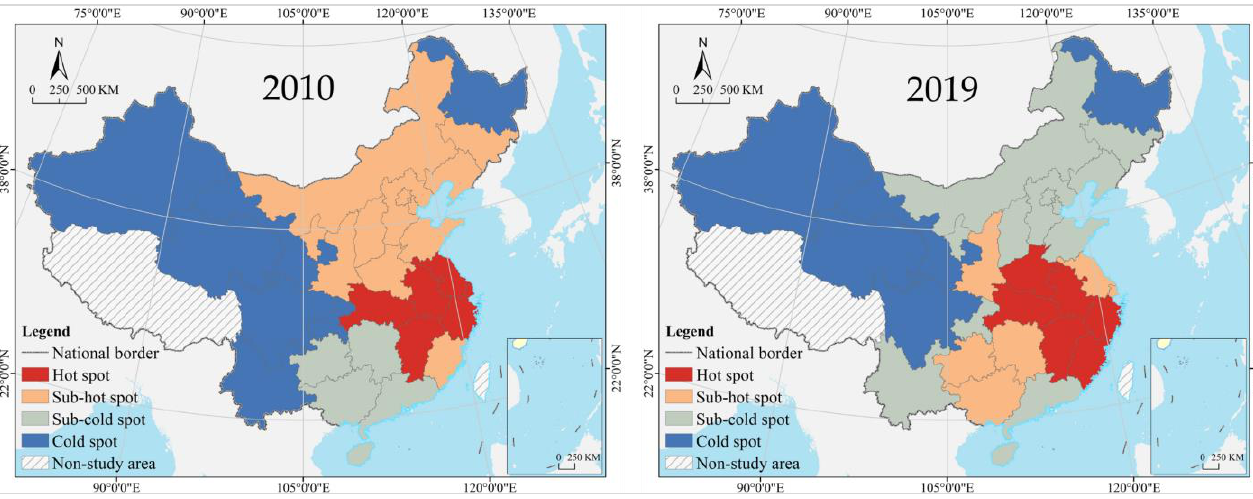
Figure 10. Spatial hot and cold spots of ECA in 2010 and 2019. For the added value, hot spots remained stable in eleven provinces, with spatial distribution further spreading to the northwest from northern and central China and Bohai Rim; sub-hot spots remained stable in five provinces, with spatial distribution shifting from central and eastern China and southern coastal areas to the northeast, northwest, and a few eastern areas; sub-cold spots decreased from twelve to seven provinces, with spatial distribution shifting to southwest, eastern, and central China from the northwest,